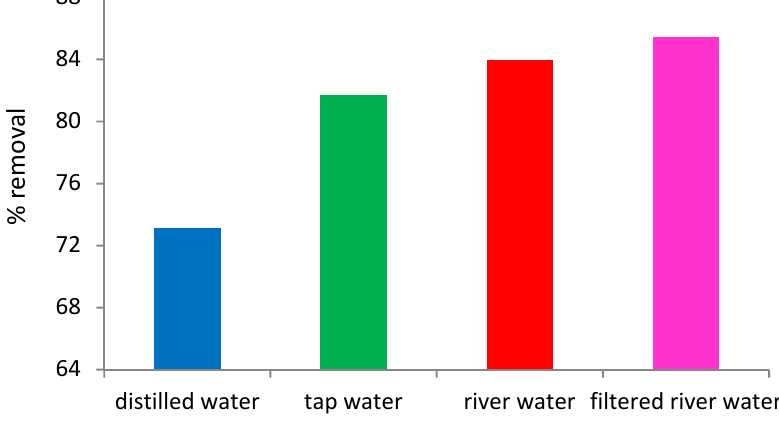
Figure 6. Effect of water collected from different sources on percentage removal of MR dye.